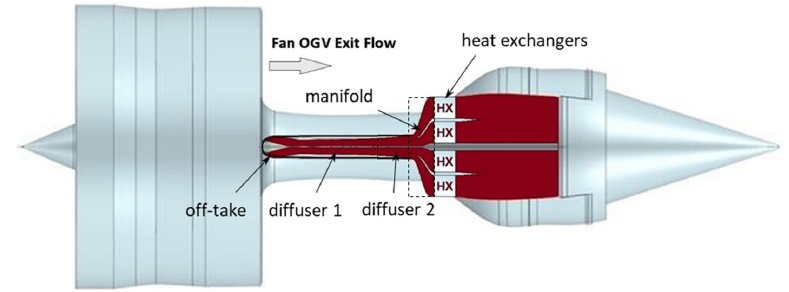
Figure 4. Schematic representation of the LP-CCA system.